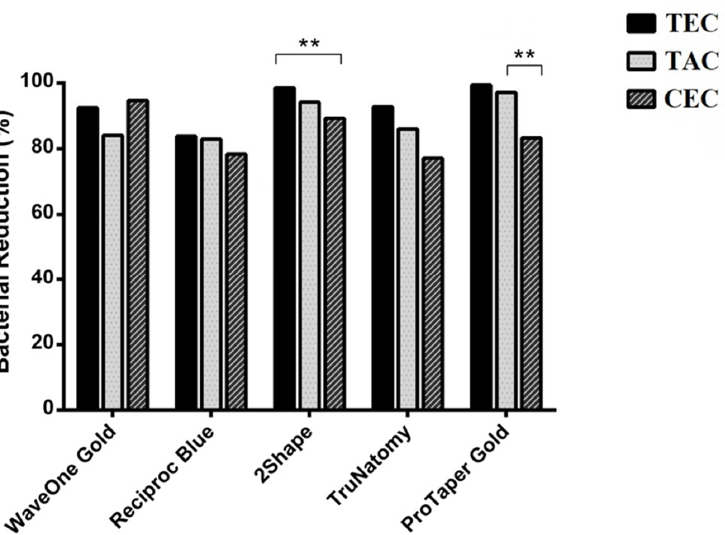
Figure 2. Percentage differences in bacterial reduction in root canals utilizing WaveOne Gold, Reciproc Blue, 2Shape, TruNatomy, and ProTaper Gold between different access cavity designs, ** p < 0.05.